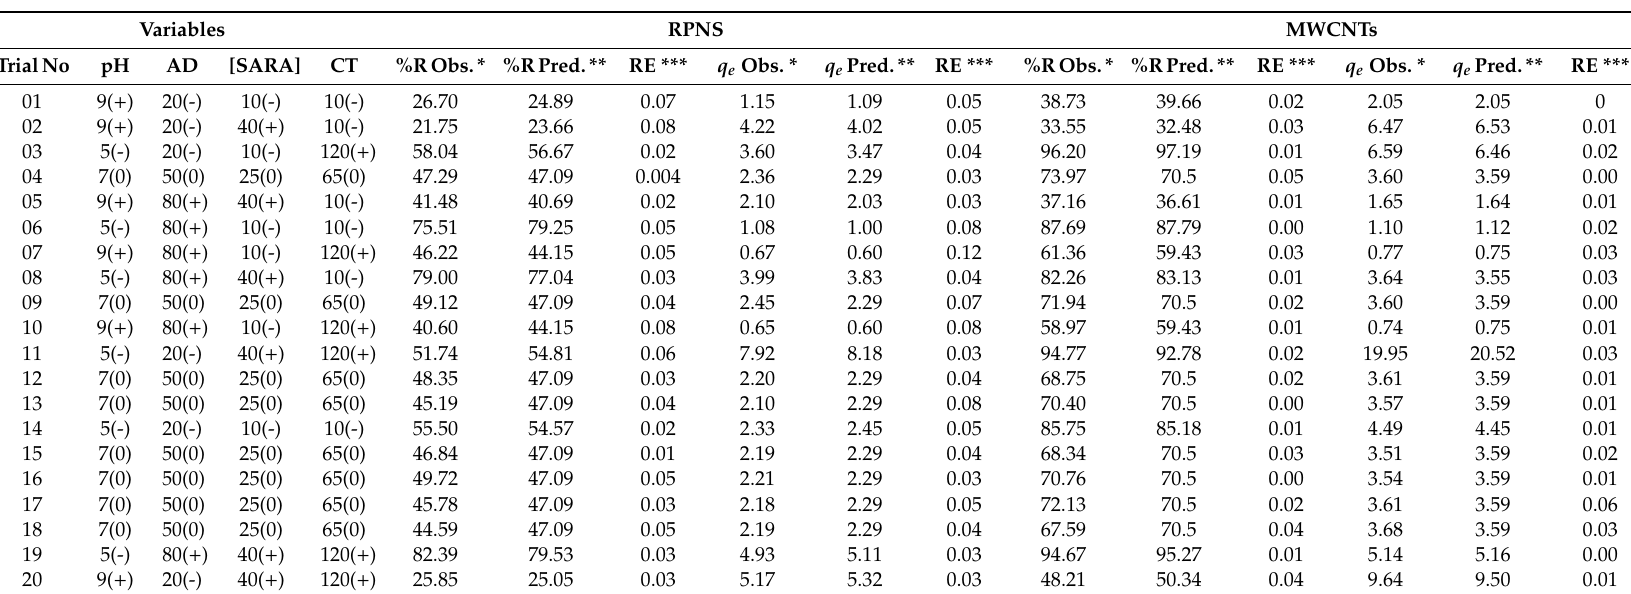
Table 4. Experimental (measured) and predicted values of the two responses using RPNS and MWCNTs as adsorbents. Di ff erence between experimental and predicted values is expressed as the relative error